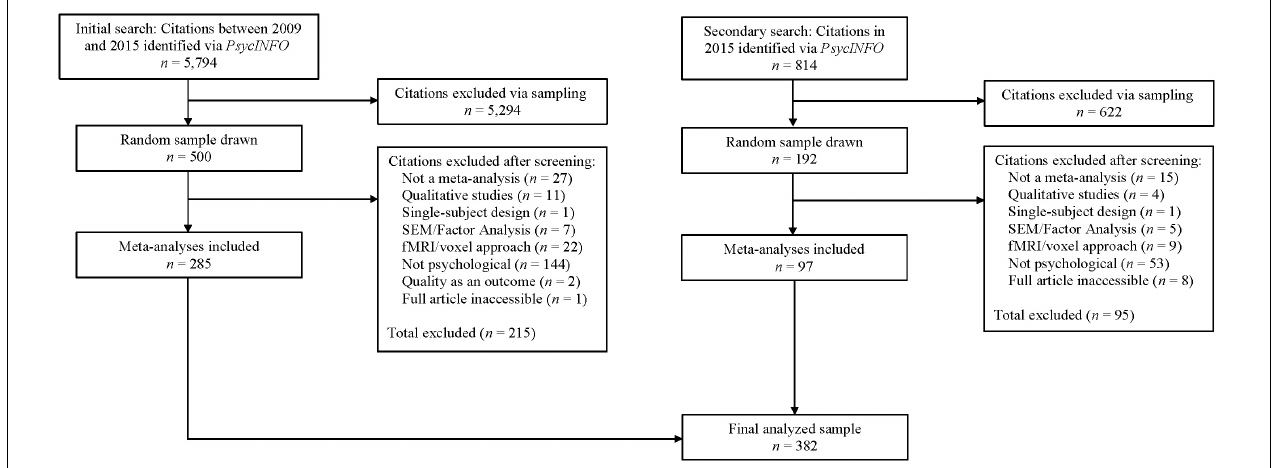
FIGURE 1 | Selection and exclusion of published meta-analyses. Note that the frequencies for “Citations excluded after screening” represent rough estimates for each exclusion criterion. At the time the samples were compiled the frequencies of exclusion for each criterion were not recorded. At the suggestion of a reviewer of this article, we attempted to obtain the frequencies post hoc by coding each excluded article for the criterion we judged most likely to be the reason it was excluded. The coding procedure was completed only by the first author of the present